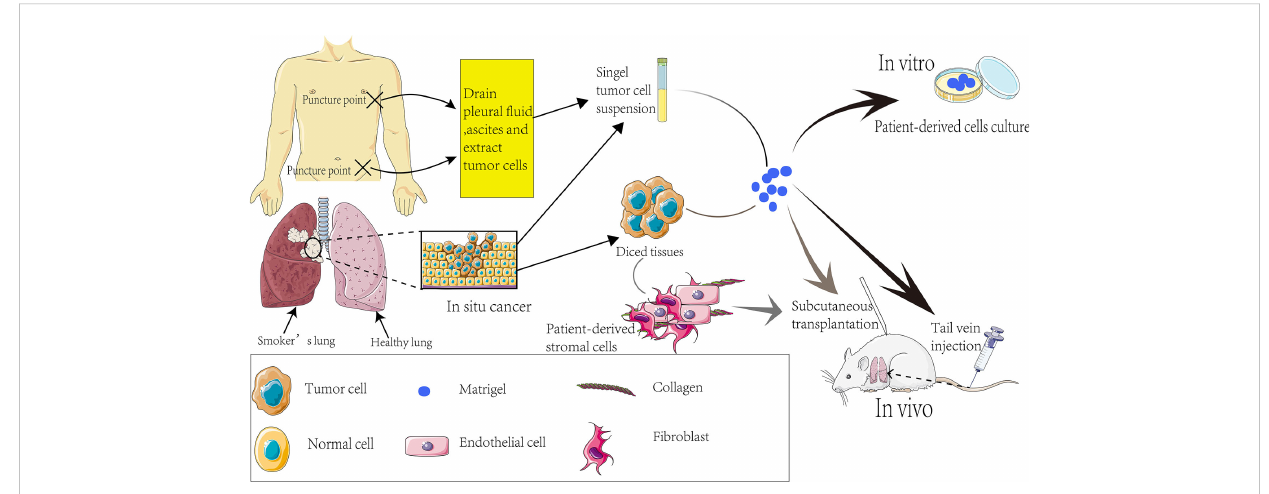
FIGURE 2 Establishment process of PDX models.